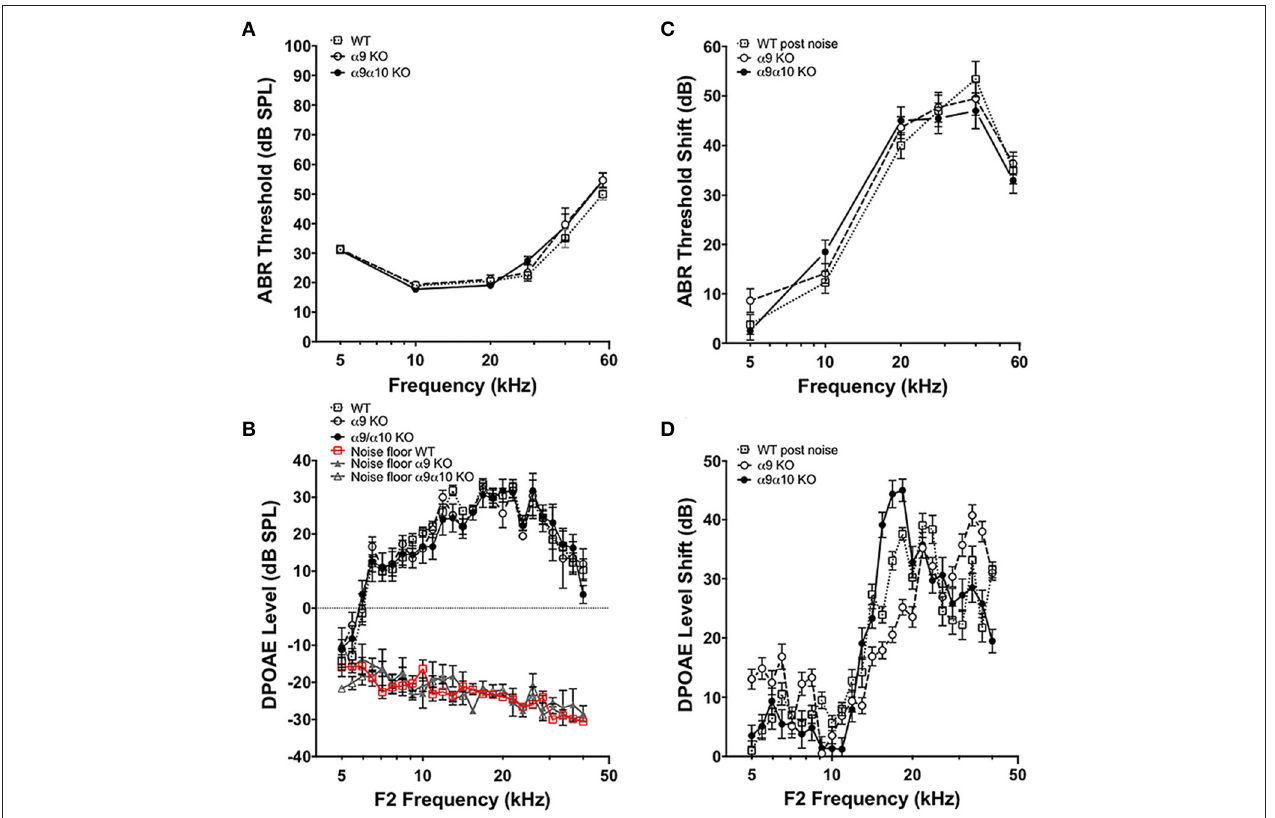
FIGURE 10 | In vivo assays of hearing thresholds. (A) Plotted are the mean ( ± s.e.m.) ABR thresholds of pre-noise exposures for 2-month-old wild-type (WT, n = 23, gray open squares), α 9 KO mutants ( n = 11, white filled circles) and α 9 α 10 KO mutants ( n = 13, black filled circles). (B) ABR threshold shift (dB) at each frequency tested for wild-type ( n = 18, gray open squares), α 9 KO mutant ( n = 11, white filled circles), and α 9 α 10 KO mutant ( n = 11, black filled circles) mice. (C) Mean ( ± s.e.m.) DPOAE levels as a function of f2 frequencies for 2-month-old wild-type (WT, n = 7, gray open squares), α 9 KO mutants ( n = 10, white filled circles), and α 9 α 10 KO mutants ( n = 8, black filled circles). The mean ( ± s.e.m.) noise floor for each genotype is also plotted for wild-type (WT, n = 7, red open squares), α 9 KO mutants (n = 10, gray filled triangles), and α 9 α 10 KO mutants ( n = 8, gray open triangles). (D) Mean ( ± s.e.m.) DPOAE shift (dB) across all f2 frequencies for wild-type (gray open squares), α 9 KO mutant (white filled circles), and α 9 α 10 KO mutant (black filled circles) mice.